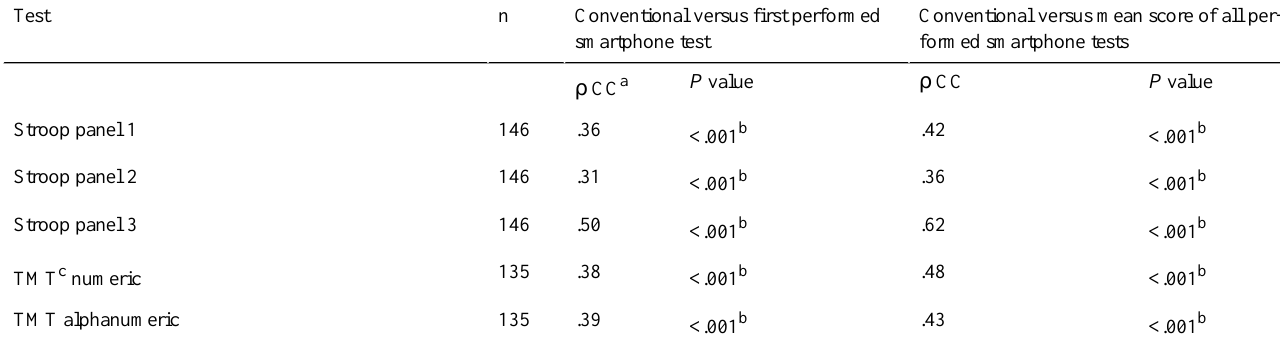
Table 3. Relative validity of conventional cognitive test at baseline compared with cognitive test on smartphone.